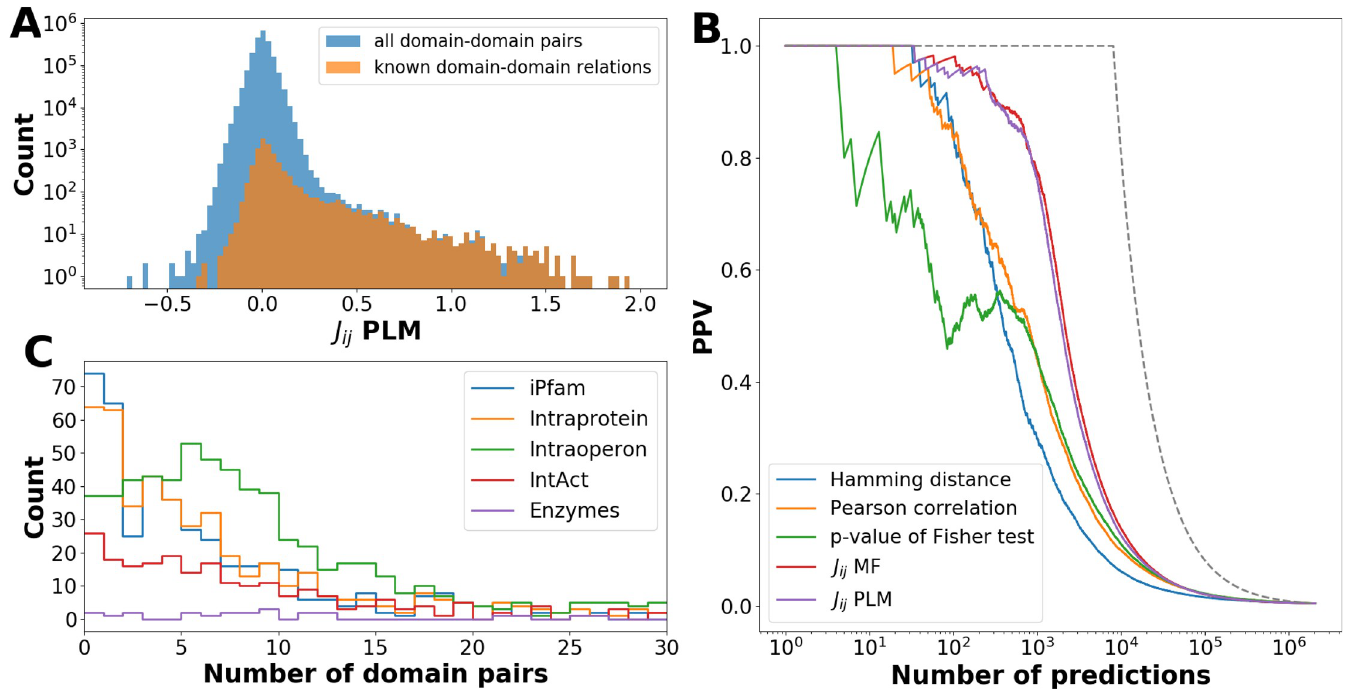
Fig 2. Phylogenetic couplings predict domain-domain relationships. – Panel A shows histograms of couplings J as inferred using pseudo-likelihood maximization ij (PLM), cf. Methods , for all domain-domain pairs (blue) and for the subset of known positive domain-domain relations (brown). The histogram shows a dominant central peak around zero (note the logarithmic scale of the counts) with a pronounced fat tail for positive couplings. In contrast to the central peak, this tail is strongly dominated by the known positive domain-domain relations. A small tail for negative couplings is visible, too, but much less pronounced. Panel B shows the PPV (positive predictive value), defined as the fraction of known domain-domain relations in between the strongest couplings or correlations. A random prediction would correspond to a flat line close to zero; a perfect prediction would follow the dashed black line. Note that the curves corresponding to phylogenetic couplings (inference vis PLM (pseudo-likelihood maximization) or MF (mean field), cf. Methods ) are substantially higher than those using correlation measures. Panel C shows, in bins of 100 domain pairs ordered by their phyletic couplings, the number of pairs belonging to the different parts of the positive-relation list (note that the categories are not exclusive, so the sum of different categories may exceed 100). We find enrichment of co-localized and interacting domain pairs, but not of related enzymes.